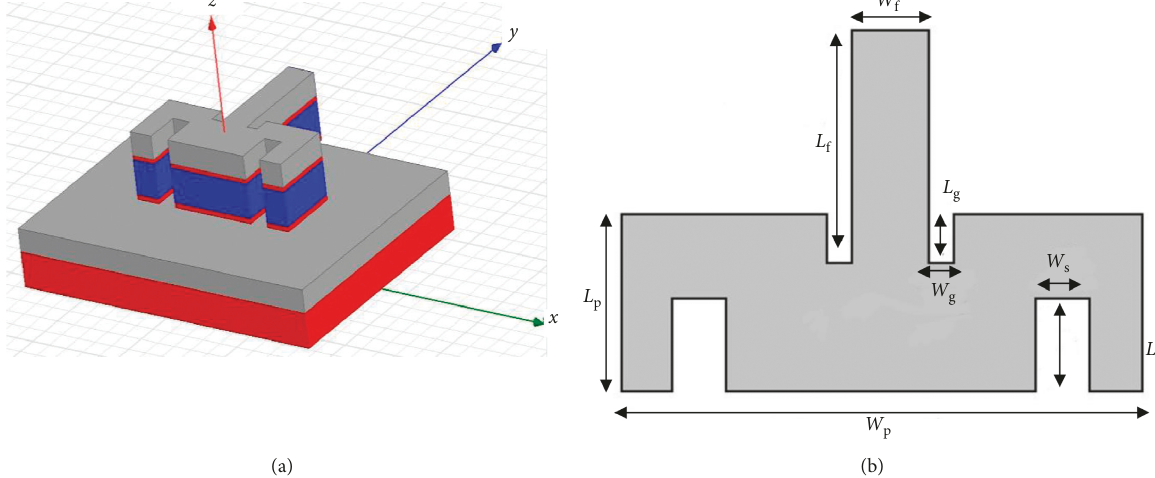
Figure 2: HMIM plasmonic rectangular nanopatch antenna with inset feed. (a) Perspective view. (b) Top view.